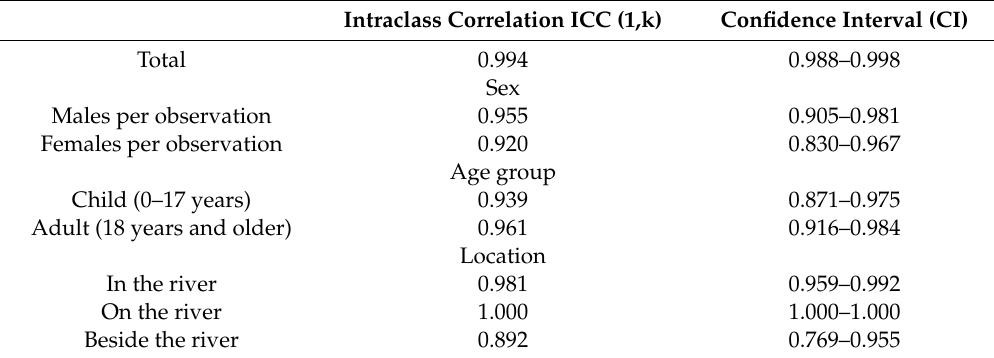
Table 5. Intraclass coe ffi cient calculations (ICC 1,k) of accuracy of observations with a minimum of two